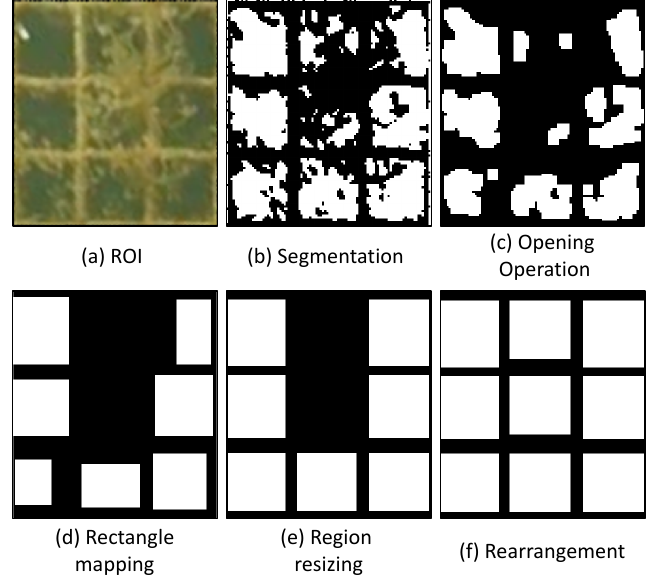
Figure 6. Intermediate results of net-opening structure analysis. ( a ) ROI; ( b ) segmentation; ( c ) opening operation; ( d ) rectangle mapping; ( e ) region resizing; and ( f )